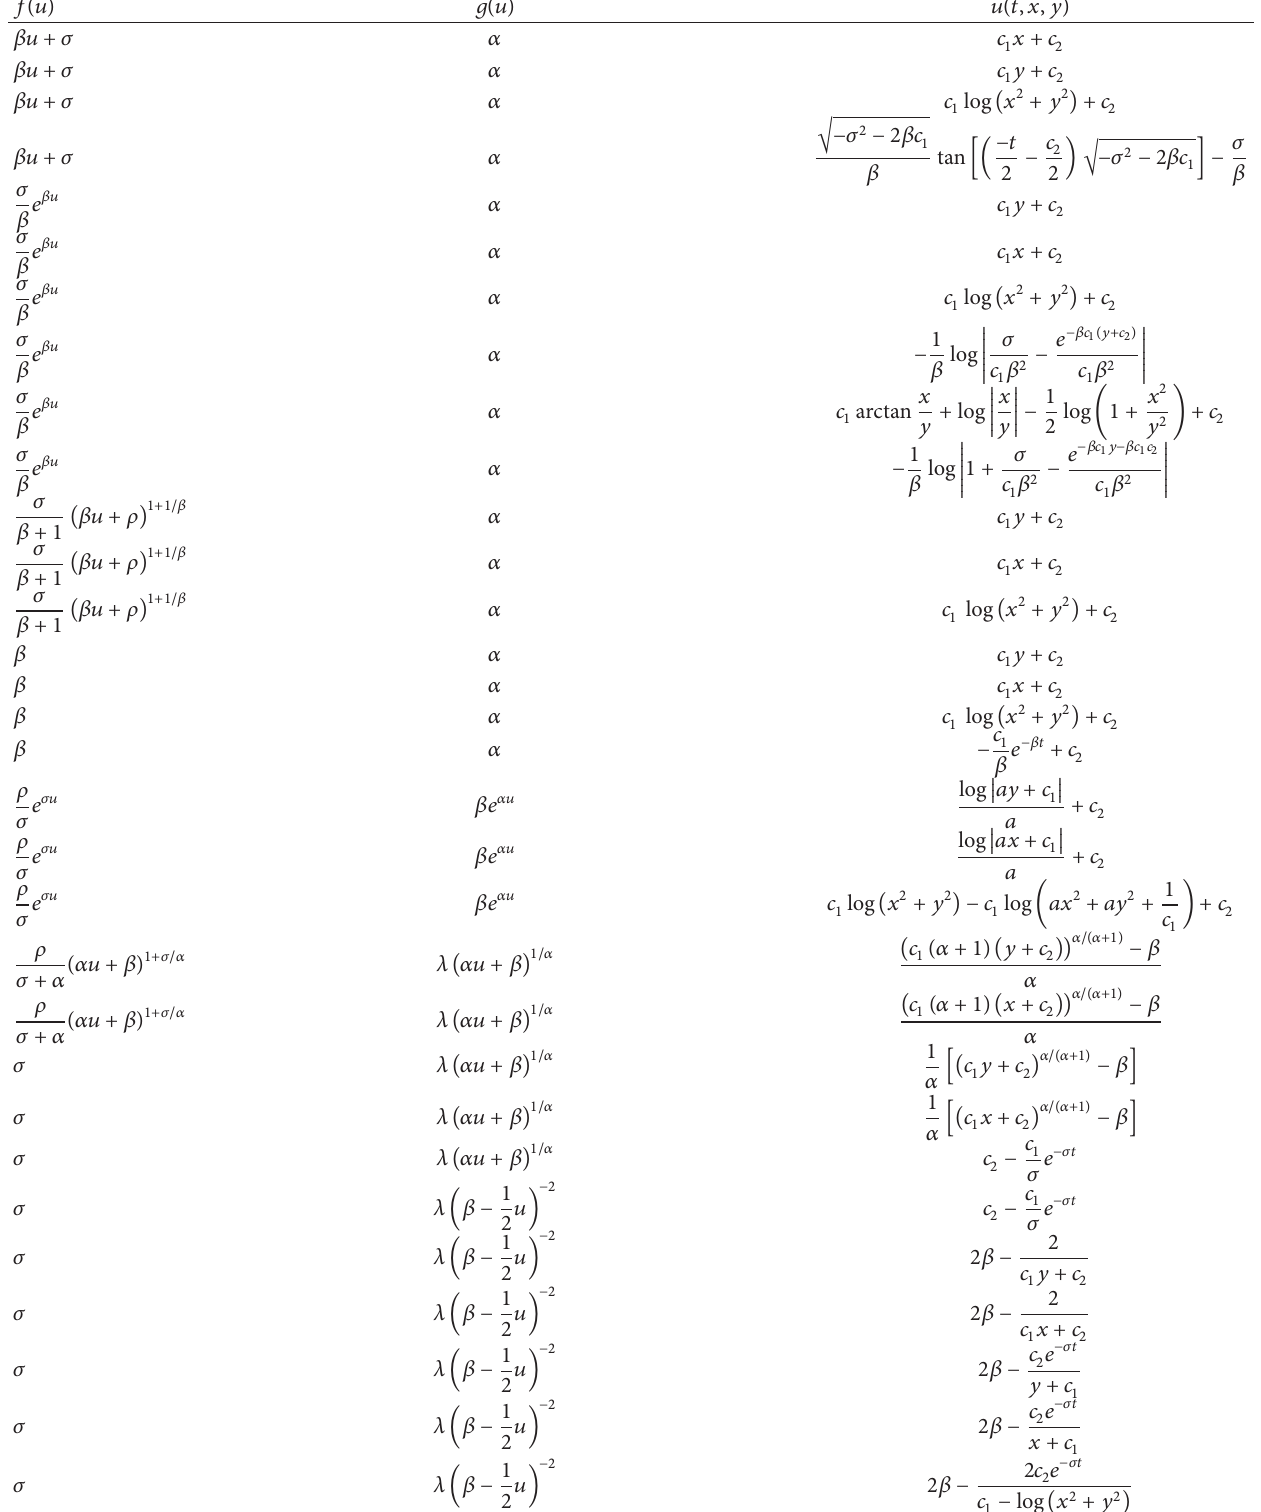
Table 3: Some exact solutions of wave equation (2) with particular forms of 𝑓 and 𝑔